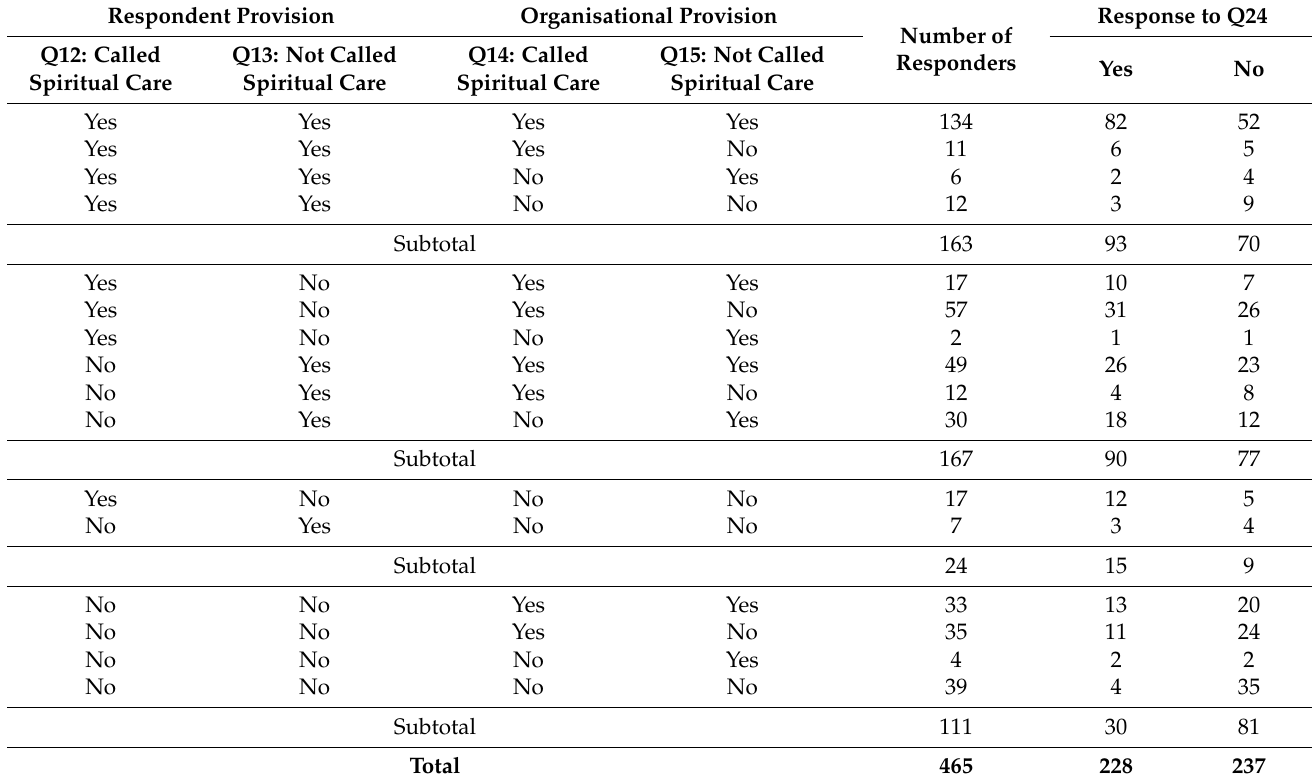
Table 6. Responses to questions 12–15 and